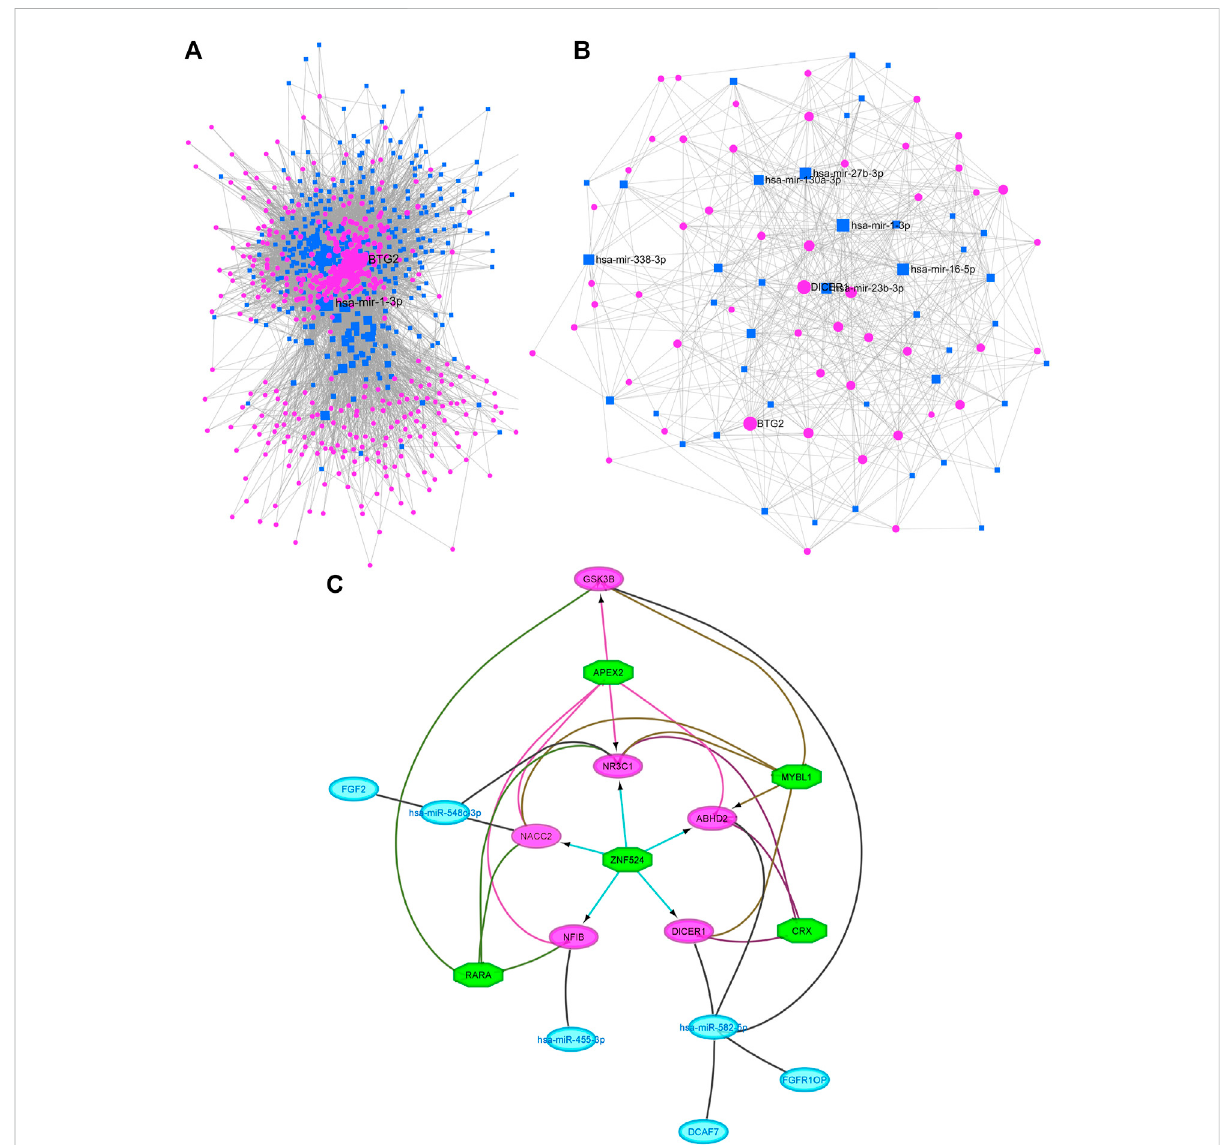
FIGURE 3 The miRNA-Protein interaction network of prostate cancer tissues. (A) The overall network of miRNAs and genes. (B) miRNA (Square)and their target hub genes (circle)with degree of centrality ( > 150). (C) Regulatory networks of the miRNAs, target genes and transcription factors. Green octagons represent TFs. Purple circles represent target genes regulated by transcription factors and key miRNAs (blue